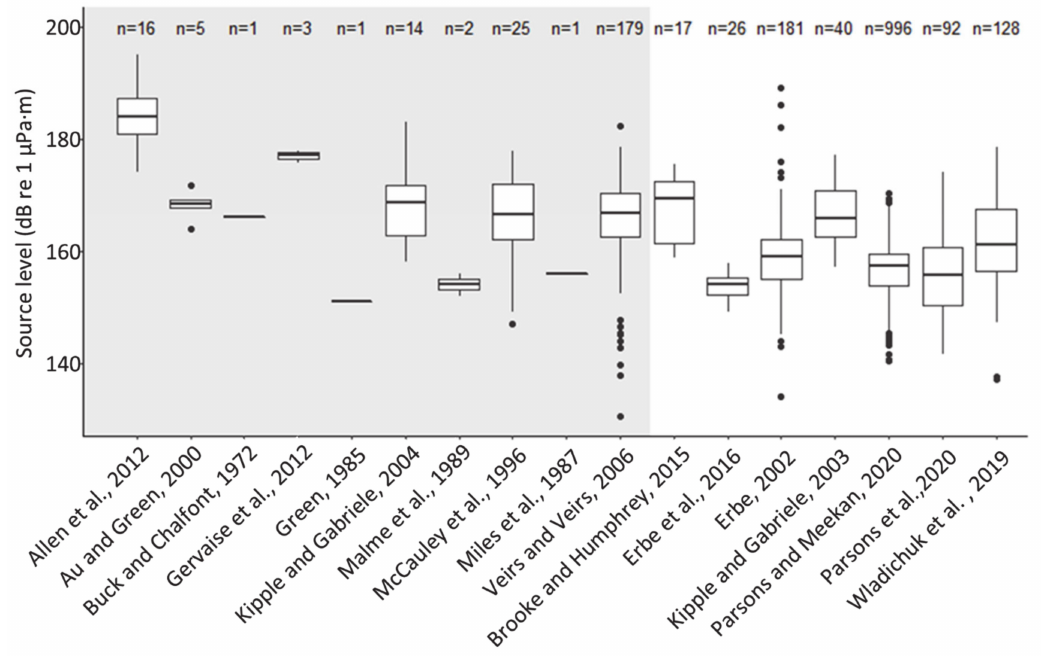
Figure 1. Box and whisker plot of reported source levels in 17 ‘Reference’ studies showing mean, inter-quartile range, 5th/95th percentiles and outliers (vertical black line, upper/lower bounds of boxes, upper and lower extents of vertical lines, and dots, respectively). Data from studies in white area were included in the final model, while data in greyed area did not provide sufficient information or data points per vessel for statistical modelling. Number of samples ( n ) available from each reference are shown